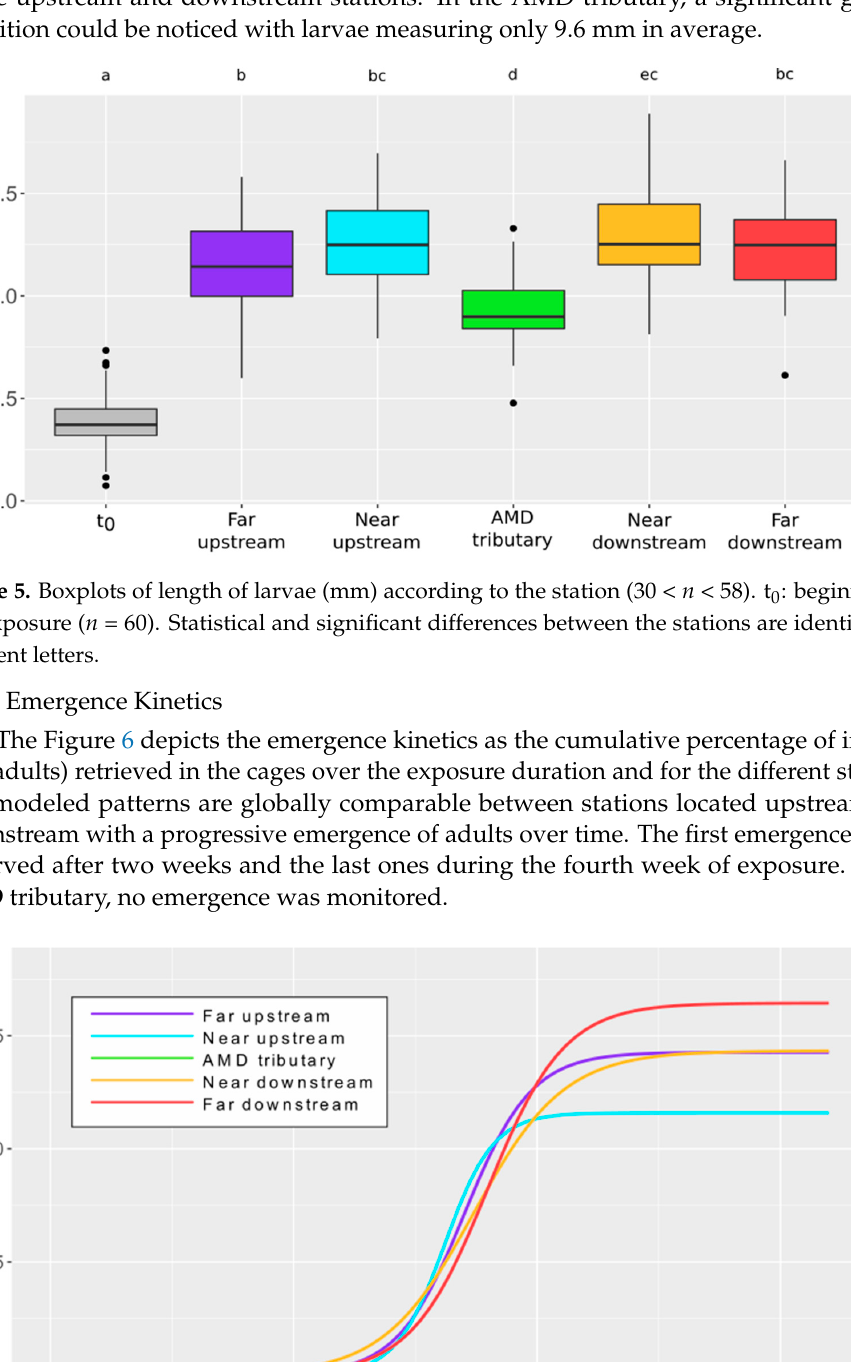
Figure 4. Boxplots of mortality percentage (%) according to the station. Statistical and significant differences between the stations are identified by different letters.